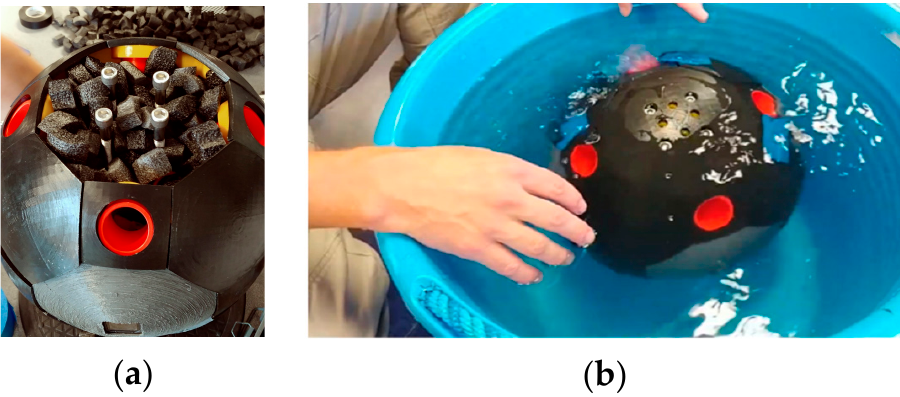
Figure 14. First fully integrated, ballasted test of the vehicle ( a ) Initially, foam insulation pieces were packed tightly inside the sphere to provide buoyancy. ( b ) Quadrant list was relieved in the early “bucket tests” with the addition of lead shot cannisters in the bottom plate’s ballast ports.